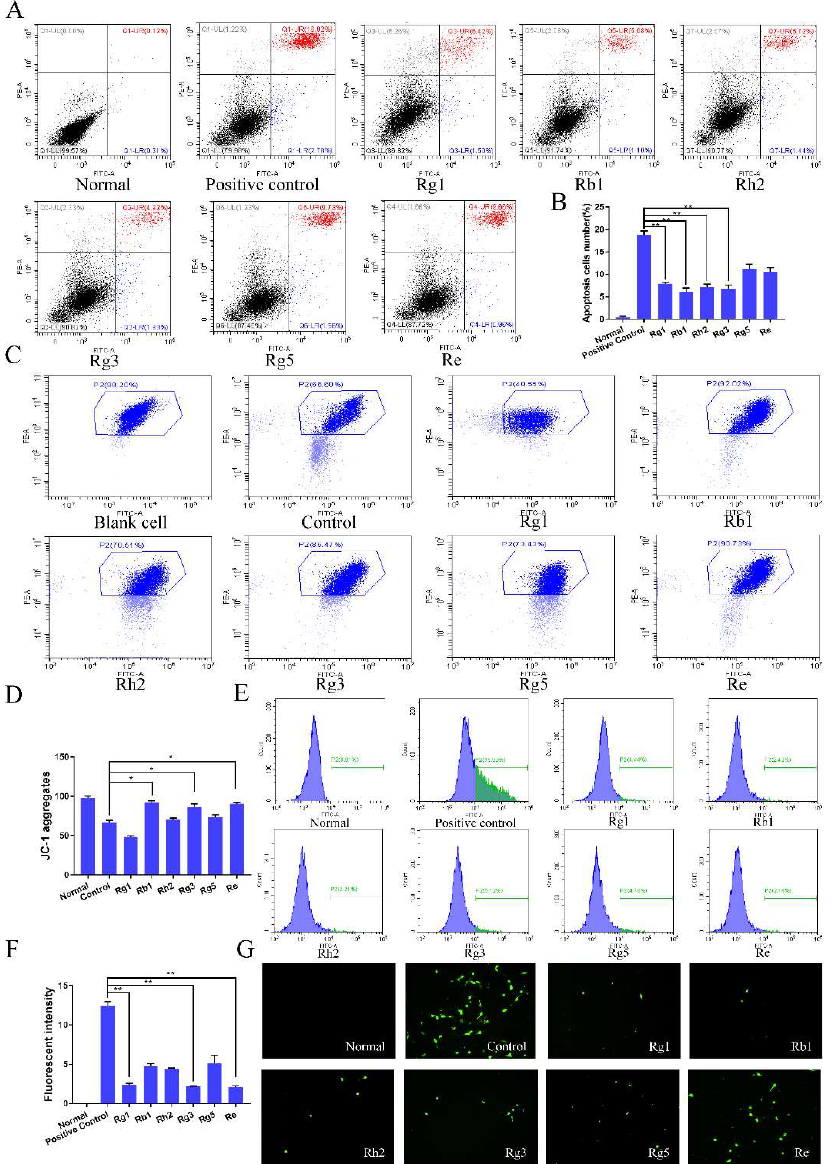
Figure 3. Effect of the ginsenosides on the apoptosis of PC12 cells. ( A ) Representative scatter plots of annexin V/PI analysis, ( B ) Percentage of apoptotic cells, including early and late apoptotic. ( C ) Representative dot plots of the distribution of JC-1 aggregates and JC-1 monomer of mitochondrial transmembrane potential (MMP). ( D ) The column chart of distribution of JC-1 cells percentage. ( E ) ROS level of PC12 cells measured by 2′,7′-dichlorofluorescin diacetate (DCFH-DA) dye dilution method. ( F ) The column chart of ROS level percentage. ( G ) Fluorescence intensity detected by inverted fluorescence microscope. Data were expressed as mean ± SD, n = 6. * p < 0.05, ** p < 0.01, compared with positive